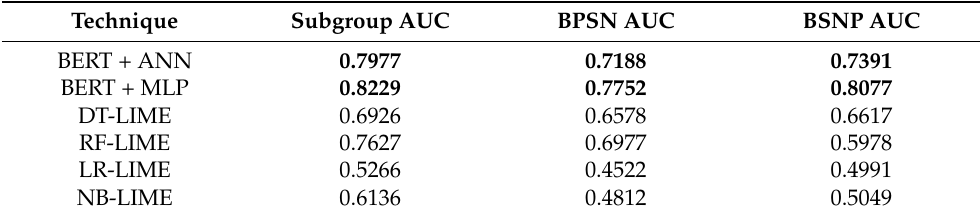
Table 10. Explainability